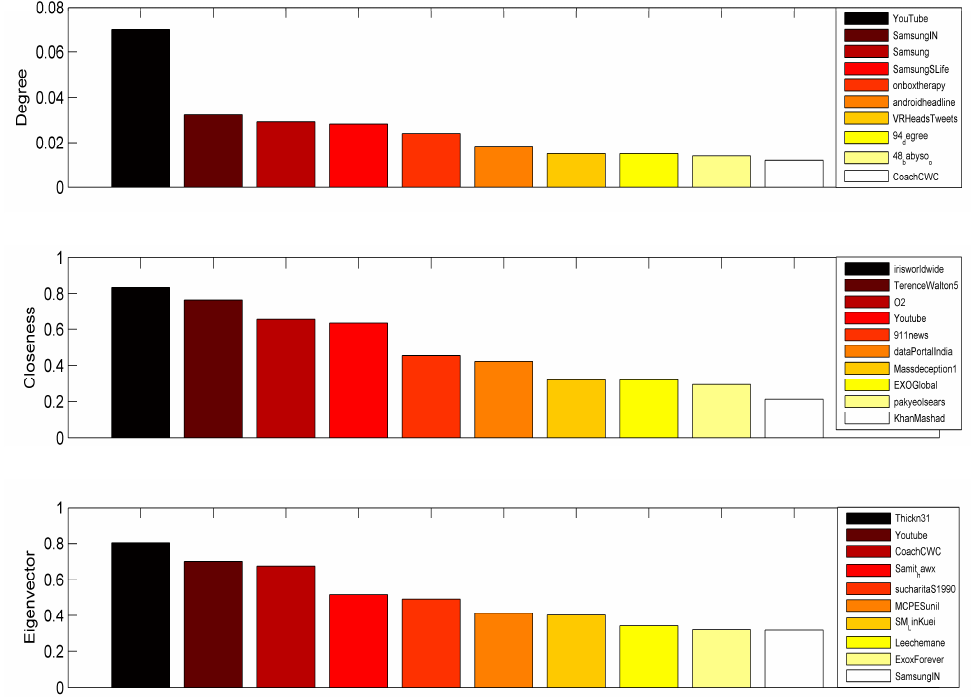
Figure 5. Top 10 central nodes under different centrality measures for day III in the Twitter dataset.